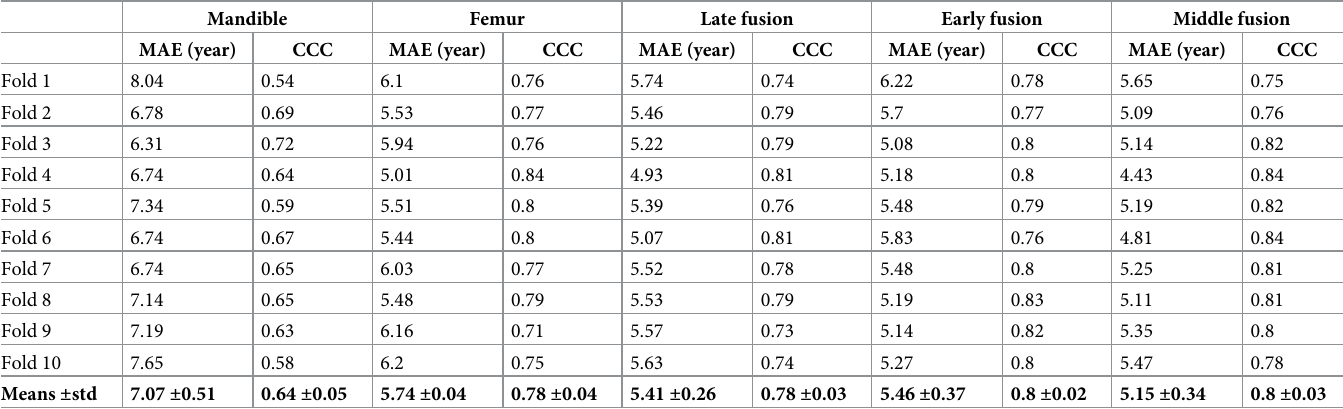
Means ± std When estimated with the first architecture, both male and female samples produced a final MAE of 7.07 years; when using the jaw and femur as age indicators, a final MAE of 5.74 years was achieved.